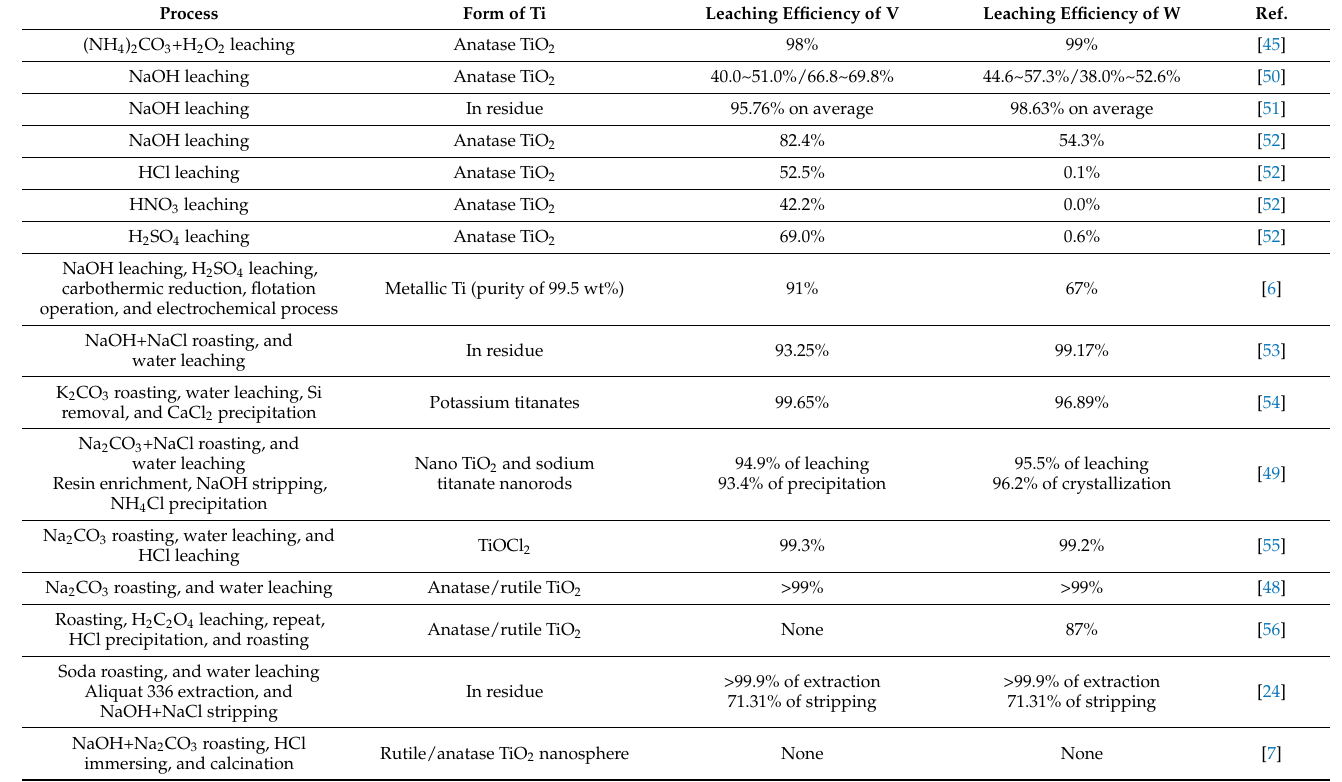
Table 2. Extraction process for spent SCR